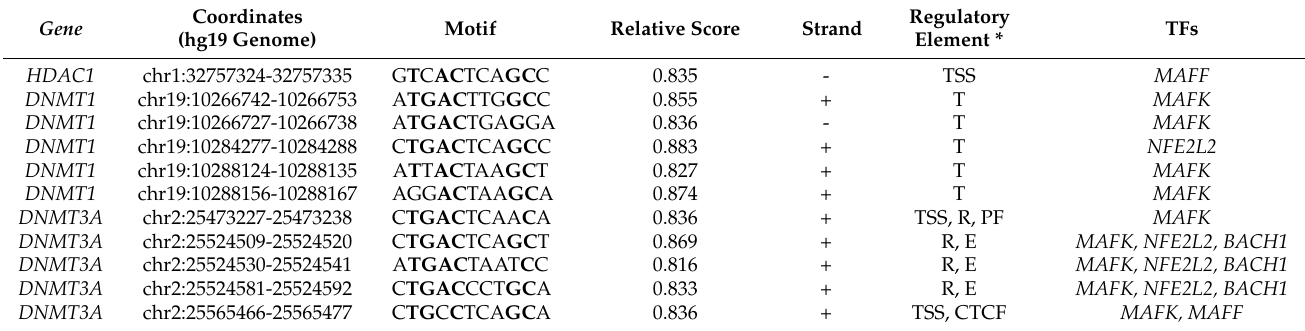
Table 1. Table showing the putative ARE sequences identified in the human genome with a relative score over 80%. Columns 1 and 2 describe the genes containing the transcription factor-binding sites and their specific locations according to the GRCh37 (hg19) human genome assembly. The Motif column contains the specific sequence that was identified as a putative ARE sequence. The TGA motif in nucleotides 2, 3, and 4 of the motifs and the GC motif in nucleotides 9 and 10 of the motif are in bold, if present. Relative scores were calculated against the consensus binding sequence according to the position frequency matrix of the JASPAR database. The strand column indicates in which strand of the DNA, relative to the transcript sense is the putative ARE sequence: sense (+) or antisense (-). The Regulatory Element column provides the segmentation annotation from the Combined Segmentation Track at the UCSC Genome Browser. The TFs column indicates the transcription factor for which the ChIP-seq site belonged in the ChIP-Atlas database. * TSS, transcription start site; T, transcribed region; R; repressive or low activity region; PF, promoter flanking region; E; enhancer; WE, weak enhancer; CTCF, CTCF-enriched